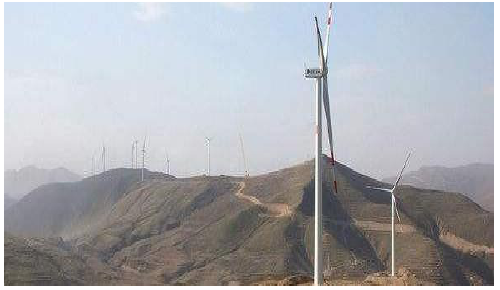
Figure 5. 100 KW medium-size wind turbines from a wind farm in Henan.